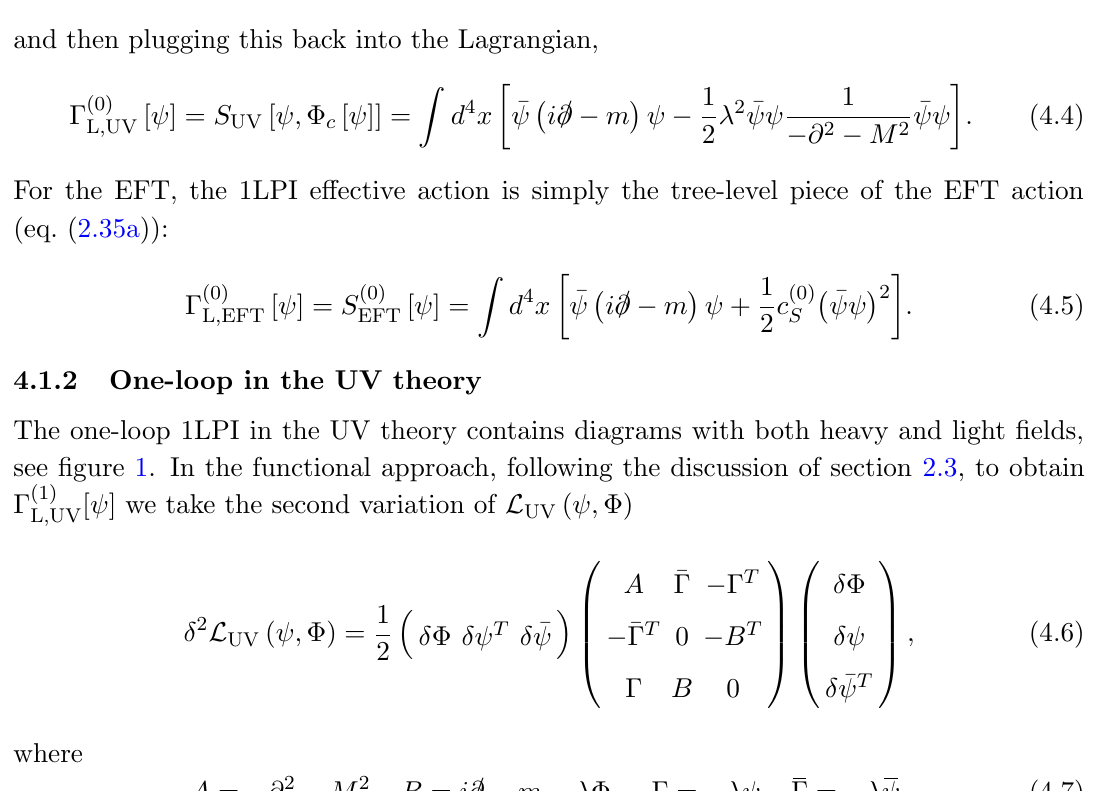
Figure 1 . One-loop diagrams contributing to the 1LPI e(cid:11)ective action in the UV theory. Solid lines represent fermions, dashed lines